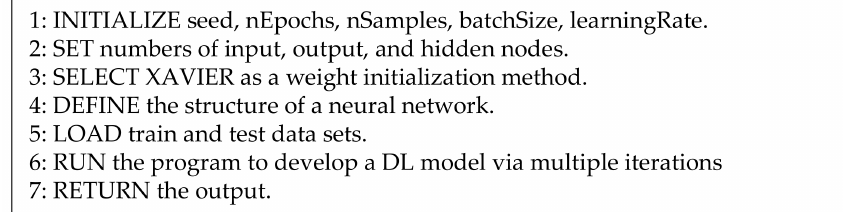
Figure 2. Pseudo code of DL with DeepLearning 4J library.